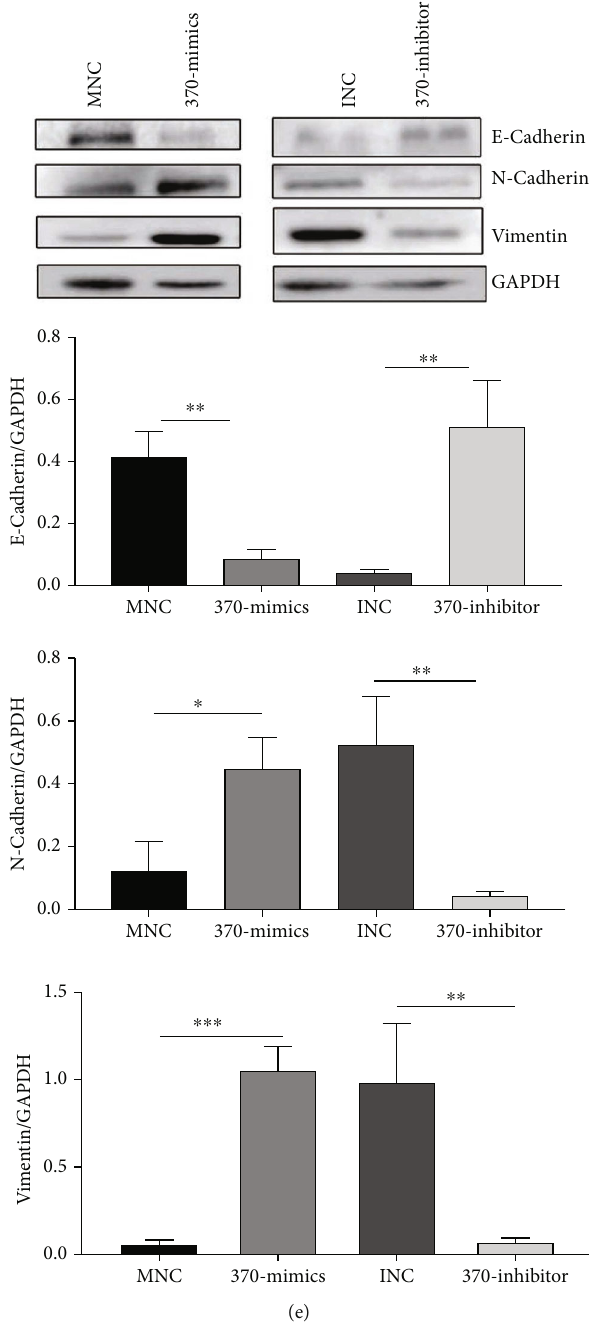
Figure 3: miR-370-3p can promote migration and proliferation of breast cancer cells in vivo. (a – c) Observe the appearance, weight, and volume of breast tumor in nude mice subcutaneously formed by MDA-MB-231 cells transfected with MNC, 370-mimics, INC, and 370- inhibitor. ∗∗ P < 0 : 01 , ∗ P < 0 : 05 . (d) The expression of miR-370-3p in the breast tumor tissues formed by MDA-MB-231 cells transfected with MNC, 370-mimics, INC, and 370-inhibitors which were injected into subcutaneous of nude mice was detected by quantitative RT- PCR. ∗∗ P < 0 : 01 , ∗∗∗ P < 0 : 001 . (e) The expression of EMT-related proteins in control and miR-370-3p-overexpressing cells or miR-370-3p knockdown cells were examined by using western blot. ∗∗∗ P < 0 : 001 , ∗∗ P < 0 : 01 , ∗ P < 0 : 05